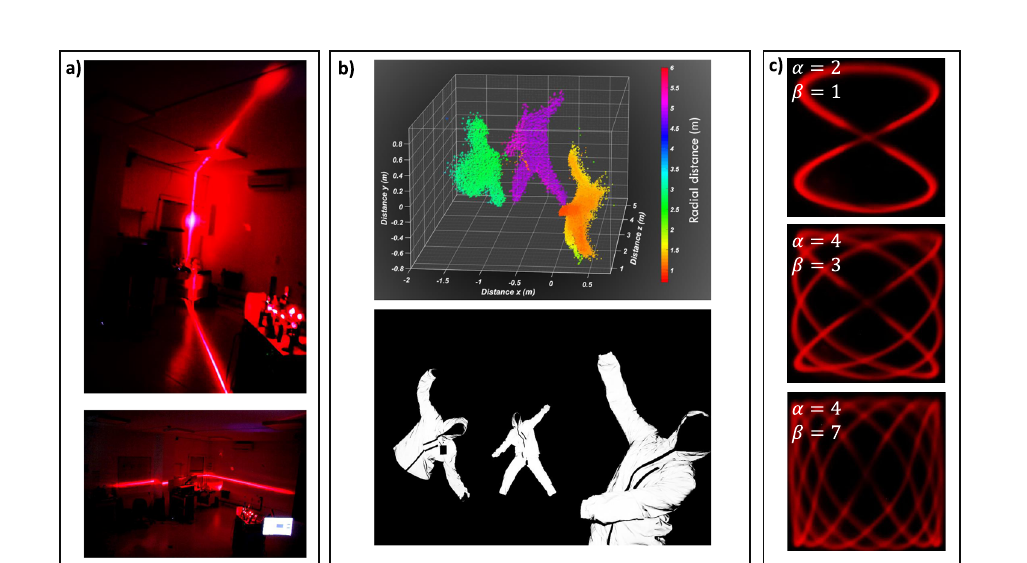
and Z (rangingdimension)showingthecapabilitiestosenseallofthethreeobjects. c Positionofsingleobjectsaccordingtorangingimagein( b ). d Rawsignalcollected for the respective image, showing that objects oriented in the normal direction have bigger scattering intensity, the inset display single pulses used to determine the ToF ranging distance.